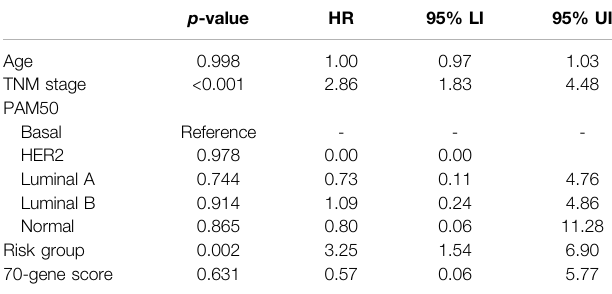
TABLE 2 | Multivariate Cox analysis of prognostic factors in TCGA